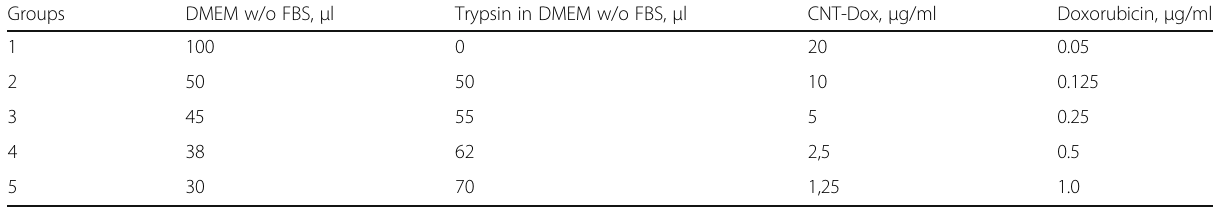
Table 2 Concentrations of trypsin, Doxorubicin, CNT-DOX, and nutrient medium for MTT-assay, after incubation during 48 h